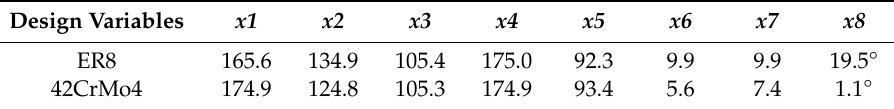
Figure 9. Optimal geometry of rail wheel profile made of steel: ( a ) ER8, mass: 38.1 kg; ( b ) 42CrMo4, mass: 33.9 kg. Table 6. Design variables (in mm) for best optimization result.